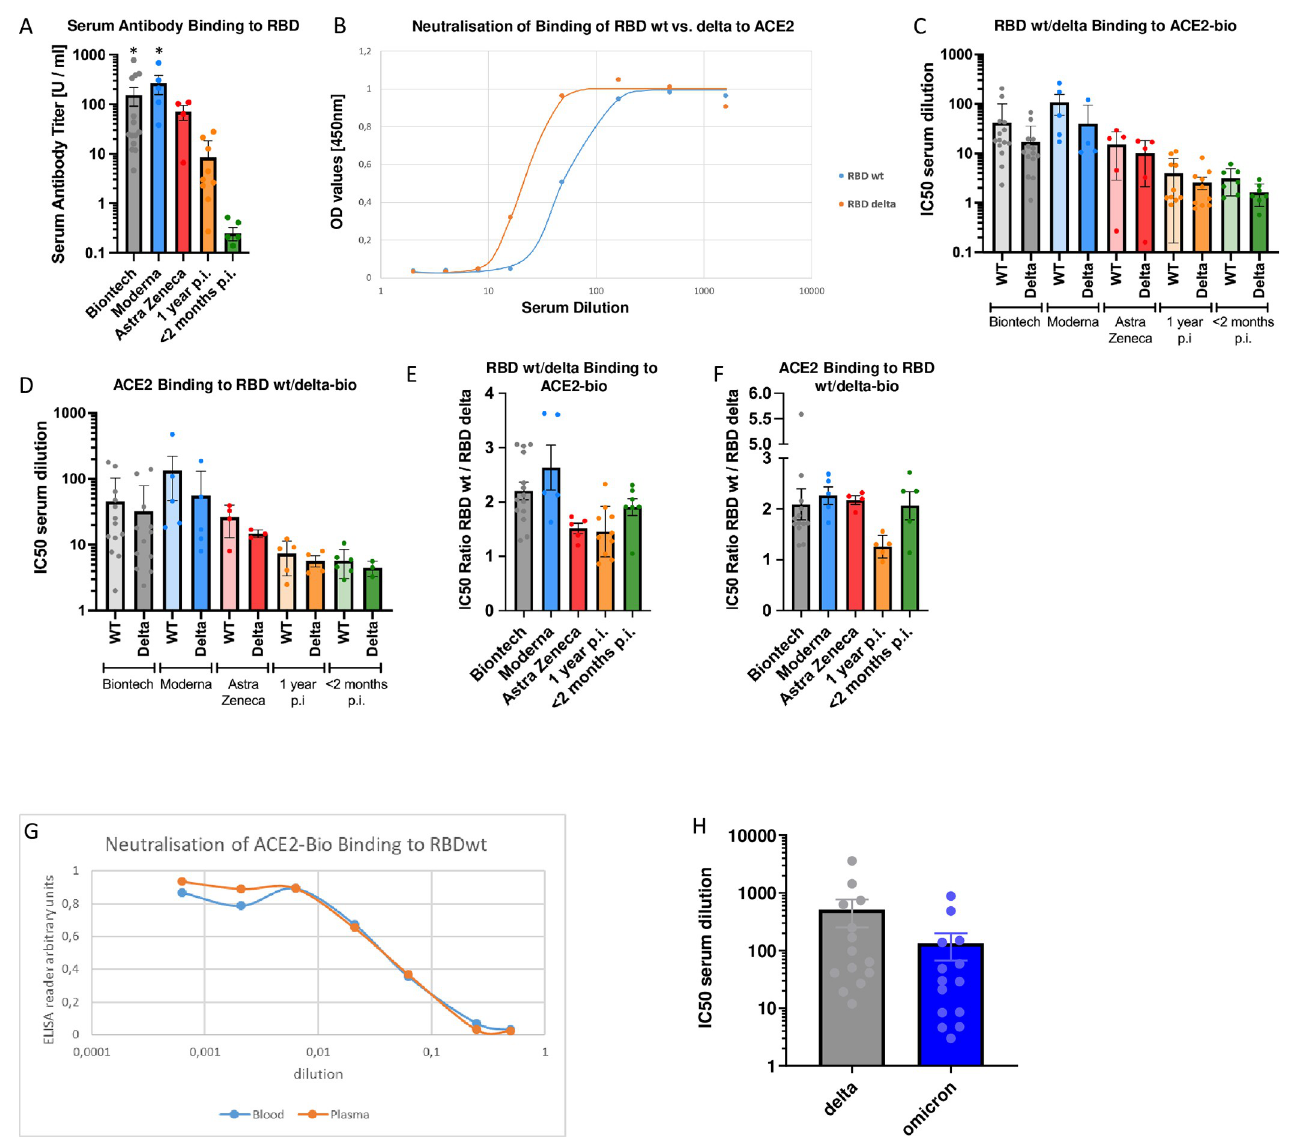
Fig 2. Serum antibodies and neutralisation. The bar graphs show results of n = 13 independent individuals after vaccination with BioNtech (grey), n = 5 Moderna (blue), n = 5 AstraZeneca (red), and n = 10 independent individuals one year (orange), and n = 7 subjects < 2 months (green) after natural infection with standard errors of the mean (SEM). Significance was tested by one-way ANOVA (A) or by Kruskal-Wallis test for non-parametric values (B–E). �� p < 0.05 vs. naturally infected subjects. A: Anti RBD antibody titres; B: Representative curve of a single experiment to determine IC50-values for the inhibition of biotinylated ACE2 binding to immobilized wt vs. delta mutant RBD. C: Absolute IC50-values calculated for the inhibition of biotinylated ACE2 binding to immobilized wt vs. delta mutant RBD. D: Absolute IC50-values calculated for the inhibition of biotinylated wt vs. delta mutant RBD binding to immobilized ACE2. E: Ratios between IC50-values calculated for inhibition of ACE2 binding to immobilized wt vs. delta mutant RBD. F: Ratios between IC50-values calculated for inhibition of wt vs. delta mutant RBD binding to immobilized ACE2. G: Read-out of a representative experiment showing the comparison between inhibition of biotinylated ACE2 binding to immobilized RBD with serum taken by venous sampling vs a drop of full blood. H: In additional, independent group of 14 subjects who had been fully vaccinated with BNT 162b2, we also investigated ratios between IC50 values calculated for inhibition of ACE2 binding to immobilized omicron vs. delta mutant